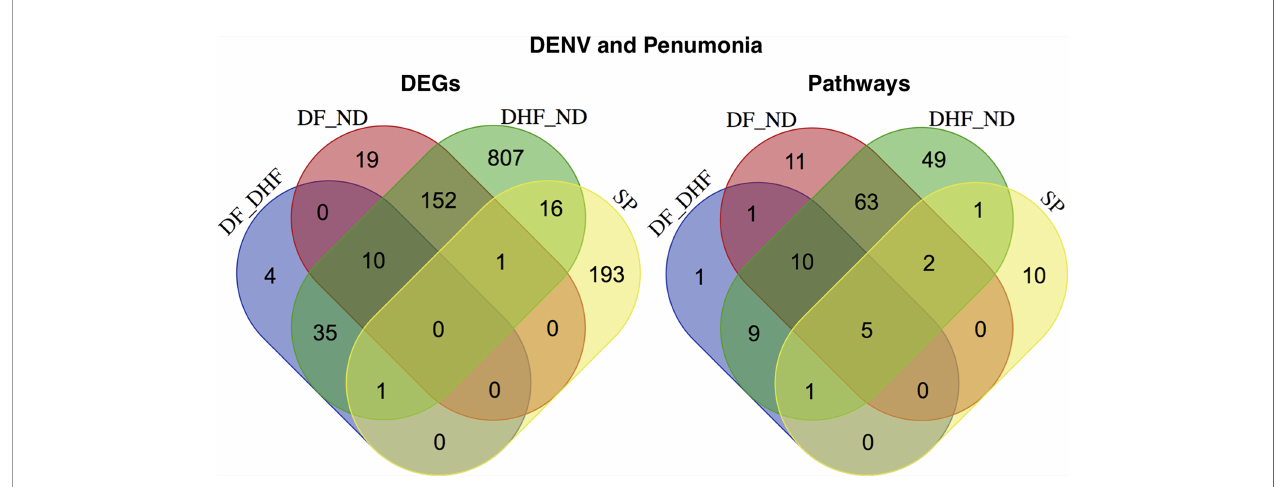
FIGURE 4 | Linkage between the DENV and Pneumoniae. Comparative study of expression patterns and the functions between DENV and